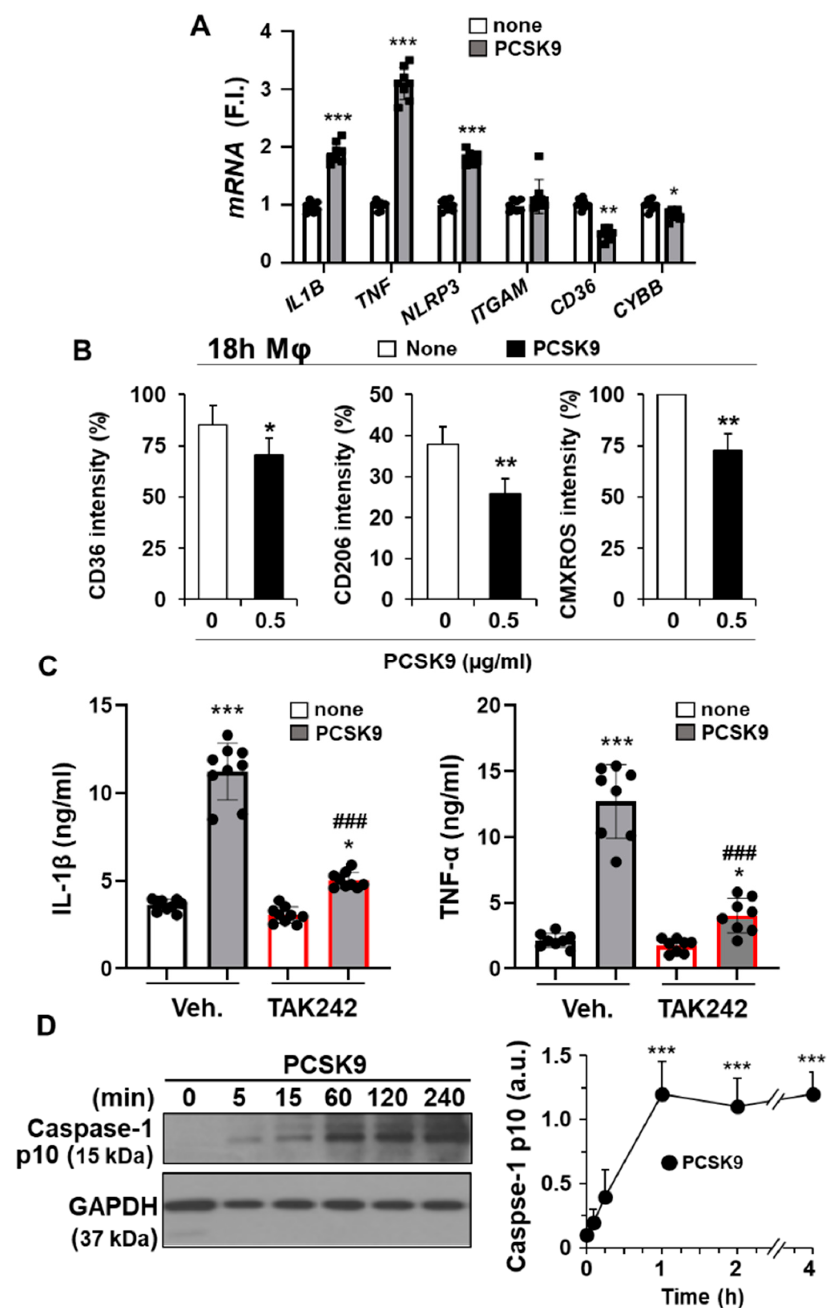
Figure 4. PCSK9 induces pro-inflammatory activation in human macrophages. ( A ) Quantification of mRNA levels of the pro-inflammatory mediators IL1B, TNF, NLRP3, ITGAM, CD36 , and CYBB after treatment of hM ϕ with 0.5 µ g/mL PCSK9. Graphs represent the mean ± SD as the fold induction (F.I.) of each experimental group using RPLP0 expression as endogenous control. ( B ) Effect of the treatment of hM ϕ with 0.5 µ g/mL PCSK9 on the cell surface levels of CD36 and CD206 and on the mitochondrial inner membrane potential, measured by the fluorescence of CMXROS. ( C ) IL-1 β and TNF- α accumulation in the culture medium of hM ϕ after 4 h of incubation with 0.5 µ g/mL of PCSK9. TAK242 (1 µ M) was added 30 min before PCSK9 incubation. ( D ) Time-course of caspase-1 processing after treatment of hM ϕ with PCSK9. Data show the mean ± SD of 6 independent donors ( A , B , D ) or a representative blot out of 4 independent experiments ( C ). * p < 0.05, ** p < 0.01, and *** p < 0.001 vs. the corresponding condition in the absence of PCSK9; ### p < 0.001 vs. the corresponding vehicle condition for TAK242 ( C , D